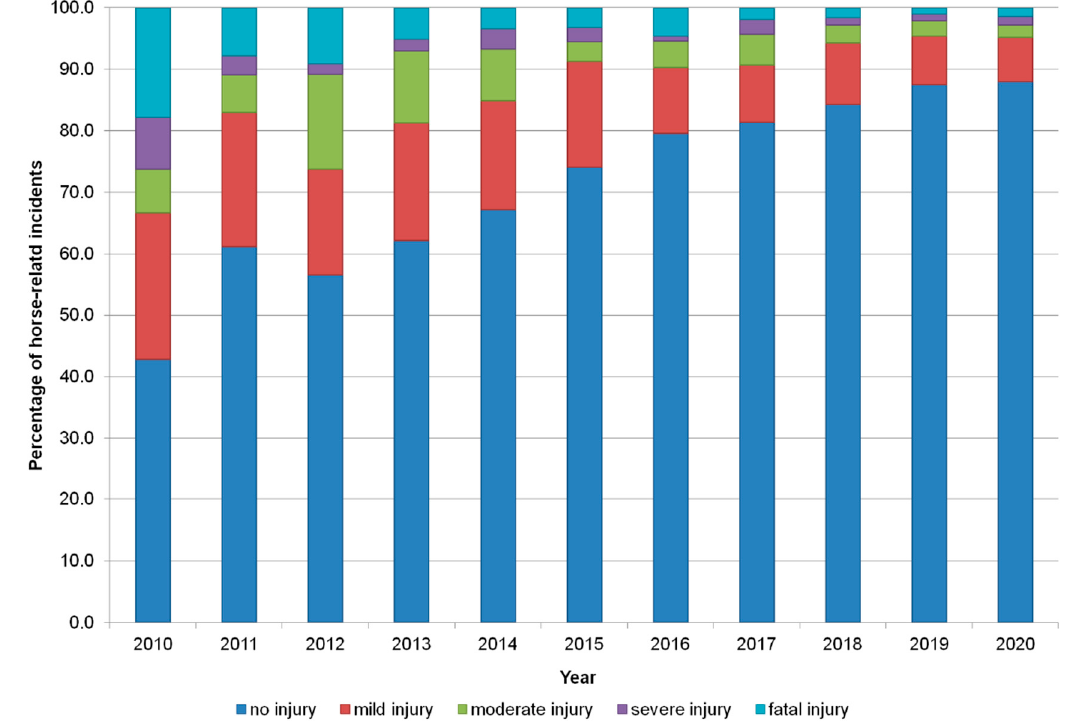
Figure 4. Road incidents ( n = 4089) between equestrians and vehicle drivers reported to the British Horse Society and injury severity sustained by the horse over an almost 10-year period (2010–September